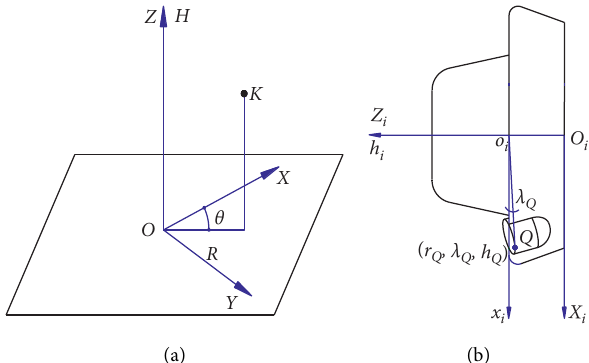
Figure 2: Coordinate systems of the scraping-wheel PDC bit. (a) Coordinate system of the bit body and (b) coordinate system of the